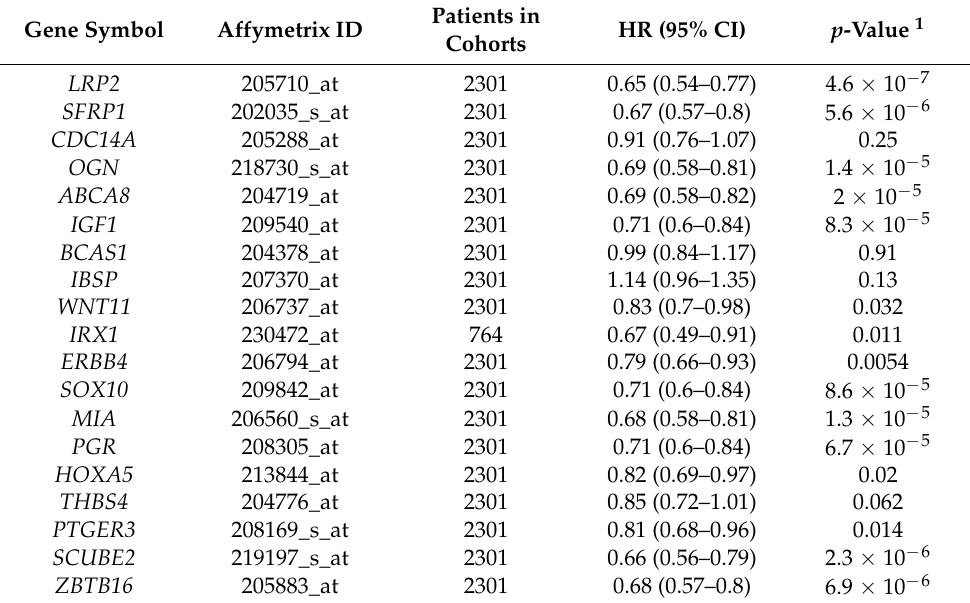
Table 3. Prognostic values of the 19 DEGs tested in ER+/HER2 − breast cancer patients that received adjuvant systemic treatment in independent breast cancer datasets (Kaplan–Meier Plotter